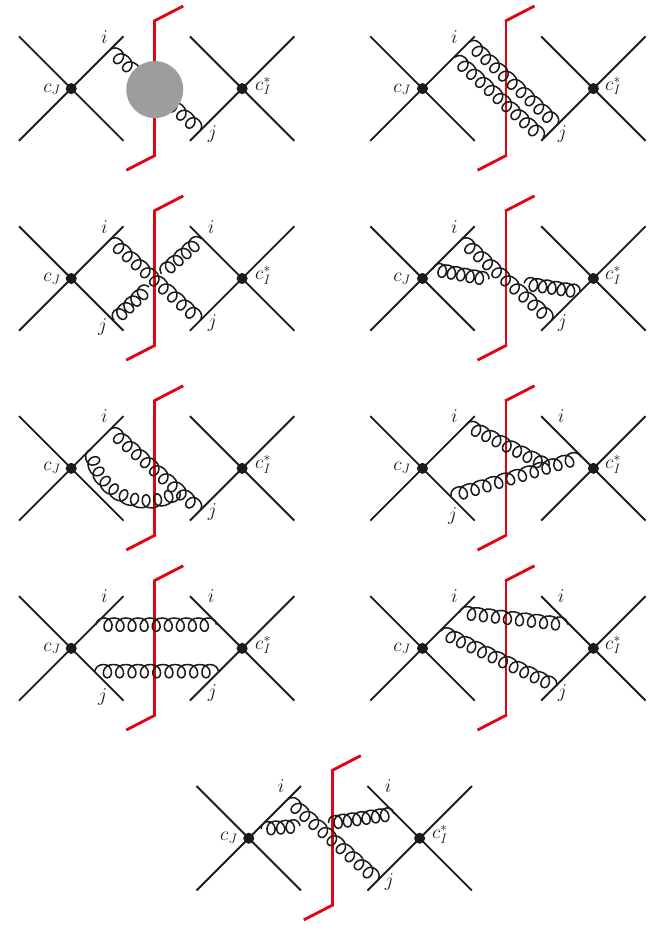
Figure 2 . Two-Wilson-line double-real diagrams contributing to the NNLO soft